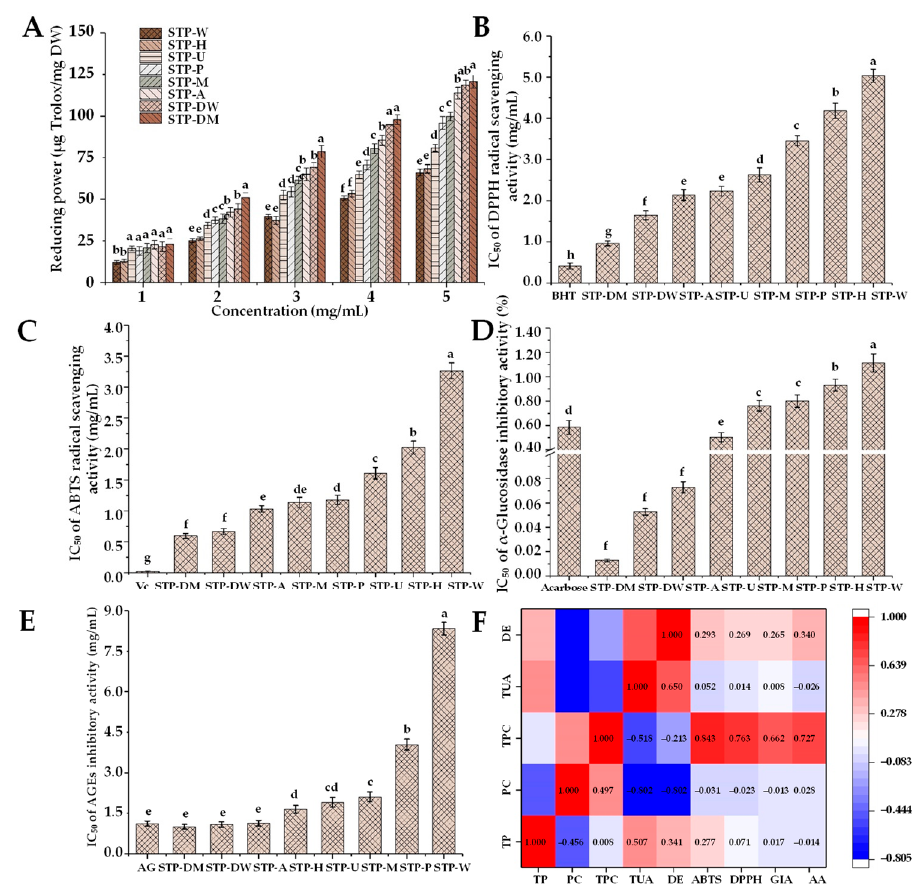
Figure 5. Reducing power ( A ), DPPH radical scavenging activity ( B ), ABTS radical scavenging activity ( C ), α -glucosidase inhibitory activity ( D ), and in vitro antiglycation activity ( E ) of STPs, and heat map analysis of the correlation between chemical composition and biological properties ( F ). STP-W, STP-M, STP-U, STP-P, STP-H, STP-DW, STP-DM, and STP-A indicate sweet tea polysaccharides extracted by hot water extraction, microwave-assisted extraction, ultrasound-microwave-assisted extraction, pressurized water extraction, high-speed shearing homogenization extraction, deep eutectic solvent-assisted extraction, deep eutectic solvent-microwave-assisted extraction, and alkali-assisted extraction, respectively. BHT, butylated hydroxytoluene; Vc, vitamin C; AG, aminoguanidine; TP, total polysaccharides; PC, protein contents; TPC, total phenolic content; TUA, total uronic acids; DE, degree of esterification; GIA, α -glucosidase inhibitory activity; AA, antiglycation activity. The error bars indicate standard deviation, and statistical analysis was carried out by ANOVA plus post hoc Duncan’s test; statistical significance ( p < 0.05) is indicated with different lowercase letters (a–h).